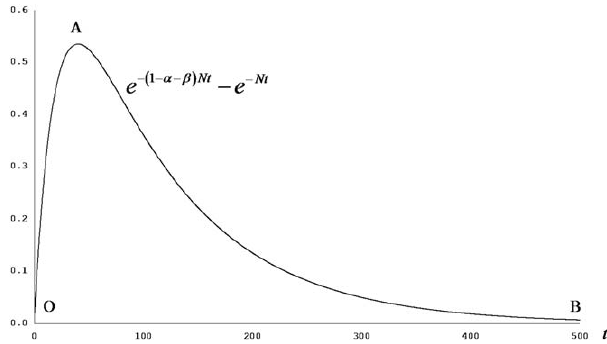
Figure 1. Capital growth premium: aid effect on capital